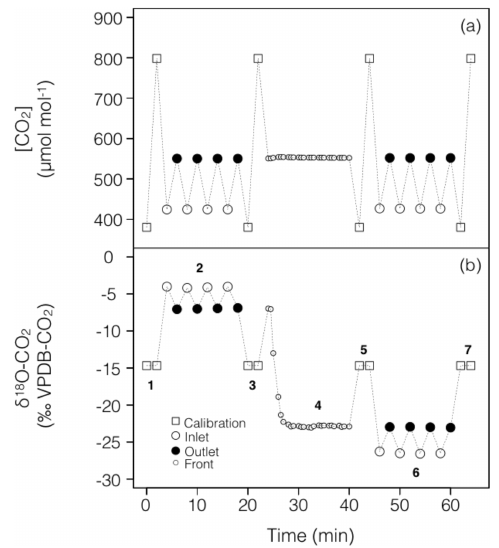
Figure 2. Typical time series of the measured CO 2 mixing ratio and isotope composition ( δ 18 O) over the course of a working sequence. The sequence is composed of seven steps (indicated in b ) to succes- sively measure: (1) two calibration bottles spanning the expected range of CO 2 mixing ratios, (2) inlet and outlet lines of the soil microcosm, measured 4 times consecutively, using a CO 2 with an enriched δ 18 O (steady state 1), (3) calibration bottles, (4) the outlet of the chamber during the switch of the air supplying the soil cham- ber (front), (5) calibration bottles, (6) inlet and outlet lines of the soil chamber, measured 4 times consecutively, using a CO 2 with a depleted δ 18 O (steady state 2) and (7) calibration